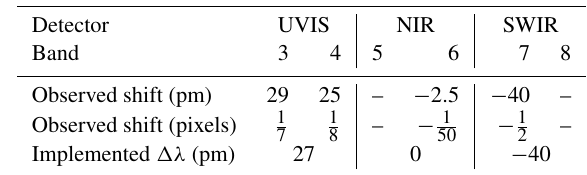
Table 3. The wavelength shift (cid:49)λ as implemented in the update of the nominal wavelength annotation CKD. Note that only one value per detector has been